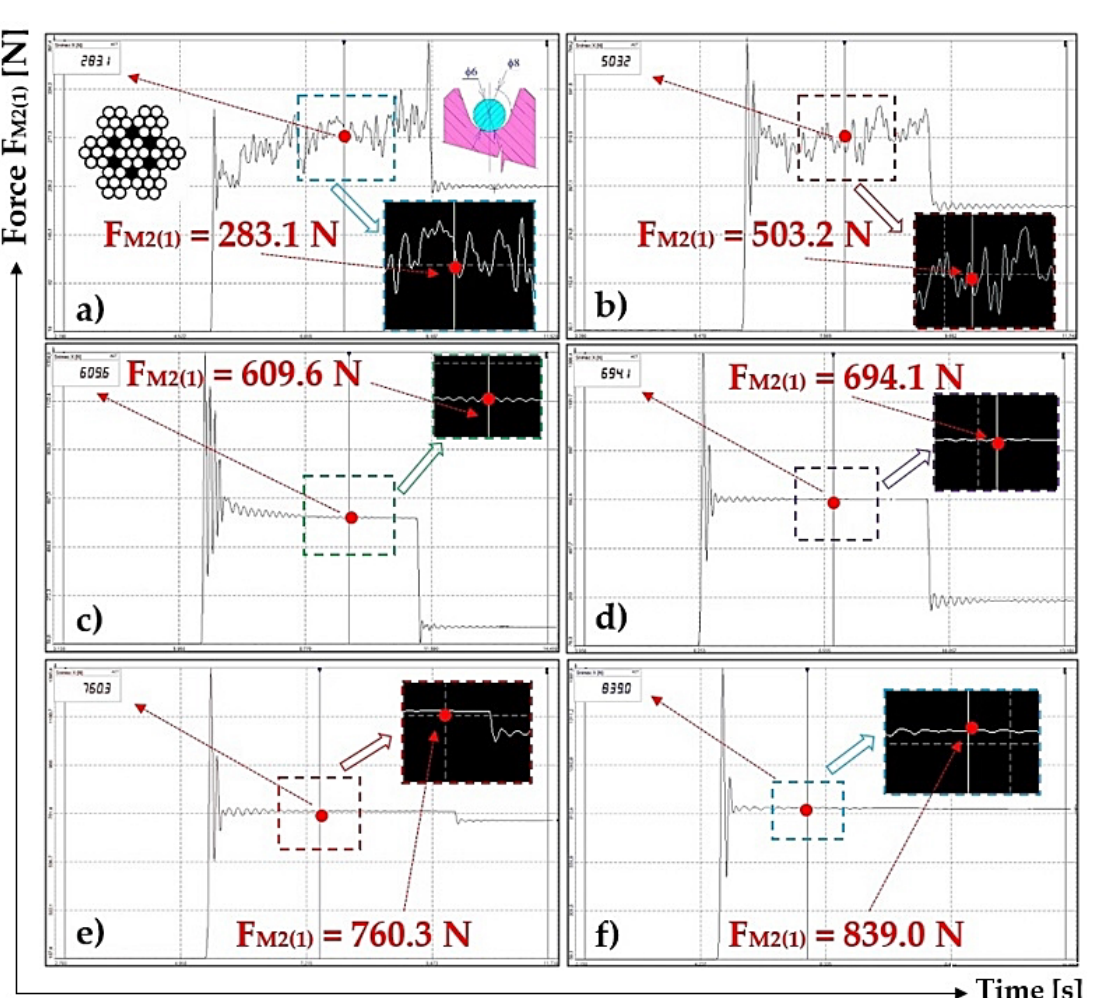
Figure 4. Recording of measured tensile forces F M2(i) [N] processed in software DeweSoft ® for a ϕ6 mm rope and semi-circular groove in clean condition (for weight of weights G z [N] ( a ) 49 N, ( b ) 98 N, ( c ) 147 N, ( d ) 196 N, ( e ) 245 N, ( f ) 294 N).